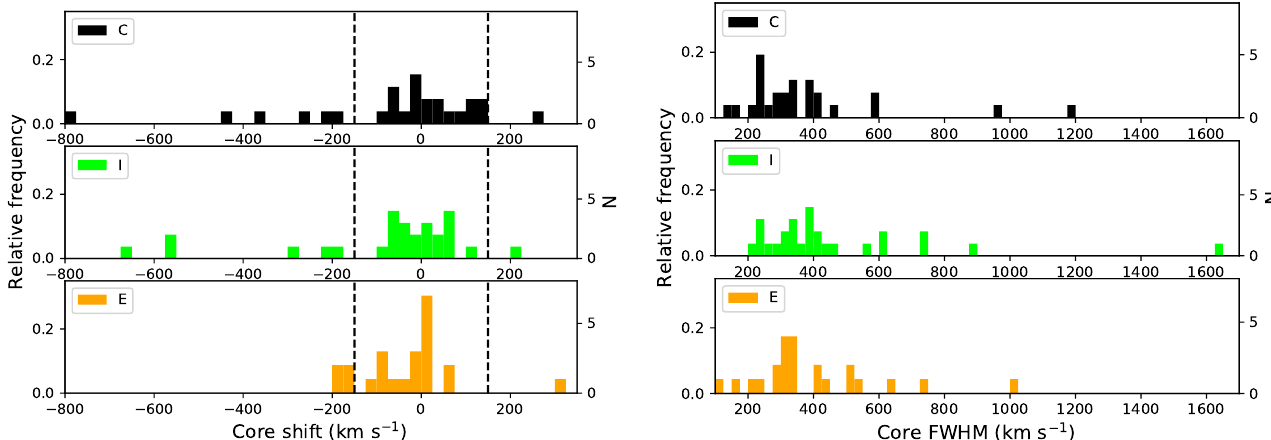
Figure 6. Left: distributions of the [O III] core velocity shift in km s − 1 , in compact (top panel), intermediate (middle panel) and extended sources (bottom panel). The vertical dashed line indicate the limit for red or blue outliers at 150 km s − 1 . Binning of 25 km s − 1 . Right: distributions of the FWHM([O III]) core component in km s − 1 in the same samples. Binning of 25 km s − 1